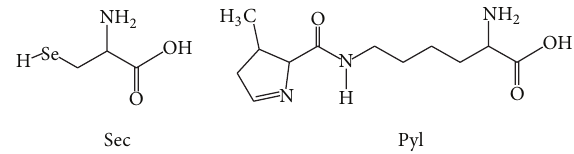
Figure 1: Chemical structures of selenocysteine (Sec) and pyrroly- sine